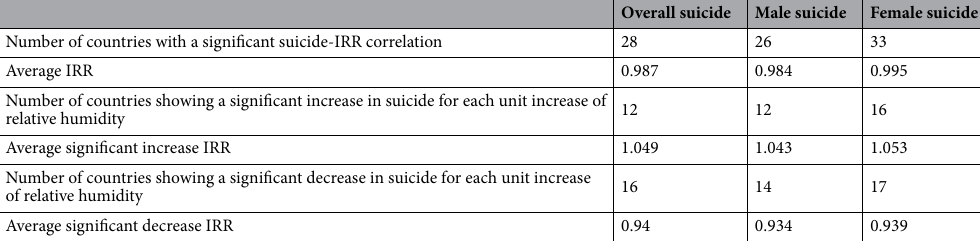
Table 3. Statistical significance of relative humidity on overall and gendered suicide.